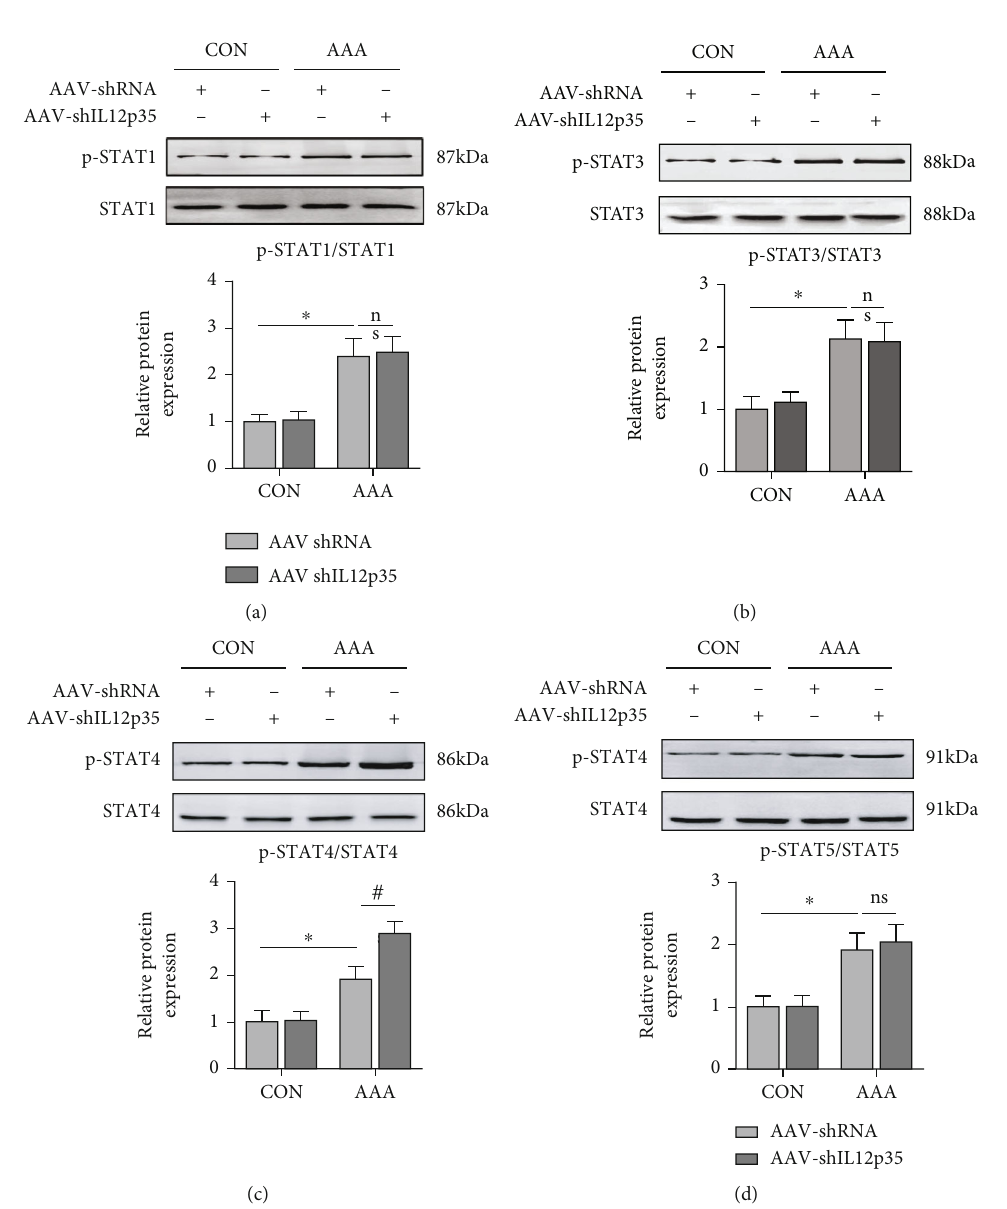
Figure 5: IL12p35 silencing activates the STAT4 signaling pathway. (a – d) Western blot analysis of the protein levels of p-STAT1, STAT1, p- STAT3, STAT3, p-STAT4, STAT4, p-STAT5, and STAT5 in the aortas of the four groups ( n = 5 per group). ∗ P < 0 : 05 compared with the control group; # P < 0 : 05 compared with the AAA